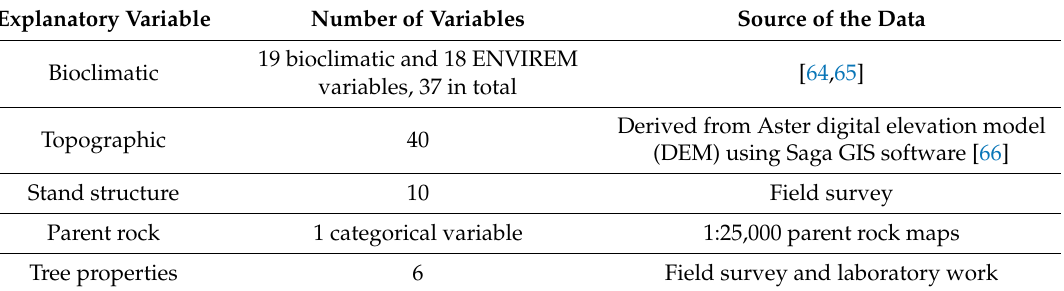
Table 1. Environmental variable groups used in the study